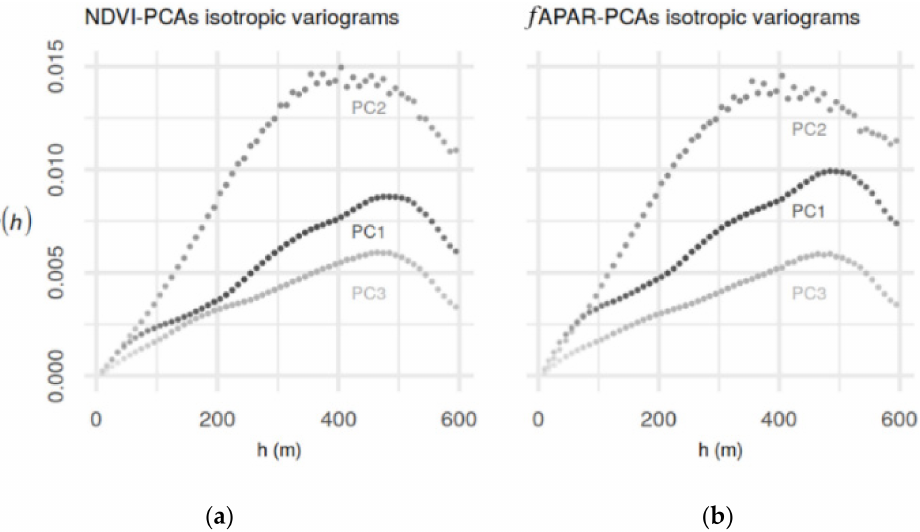
Figure 7. Biophysical parameter PCAs isotropic variograms (pixel-wise or 10 m lag), for NDVI-PCAs ( a ) and fAPAR-PCAs ( b ). Table 6. Ridge regression results between selected covariates and aggregated VNIR data (n = 4965). Aggregated VNIR Soil